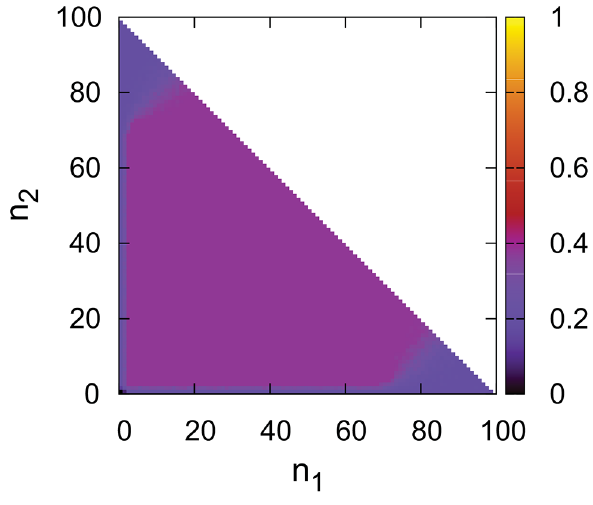
Figure 4. Dynamics of the nonlinear model with DpB update ruleinfunctionof initialsizes of P blocks ( n 1 and n 2 respectively). N ~ 100 , l ~ 10 , c 0 ~ 0 : 04 , a ~ 1 , d ~ 0 : 01 . Values are averages of 50 independent